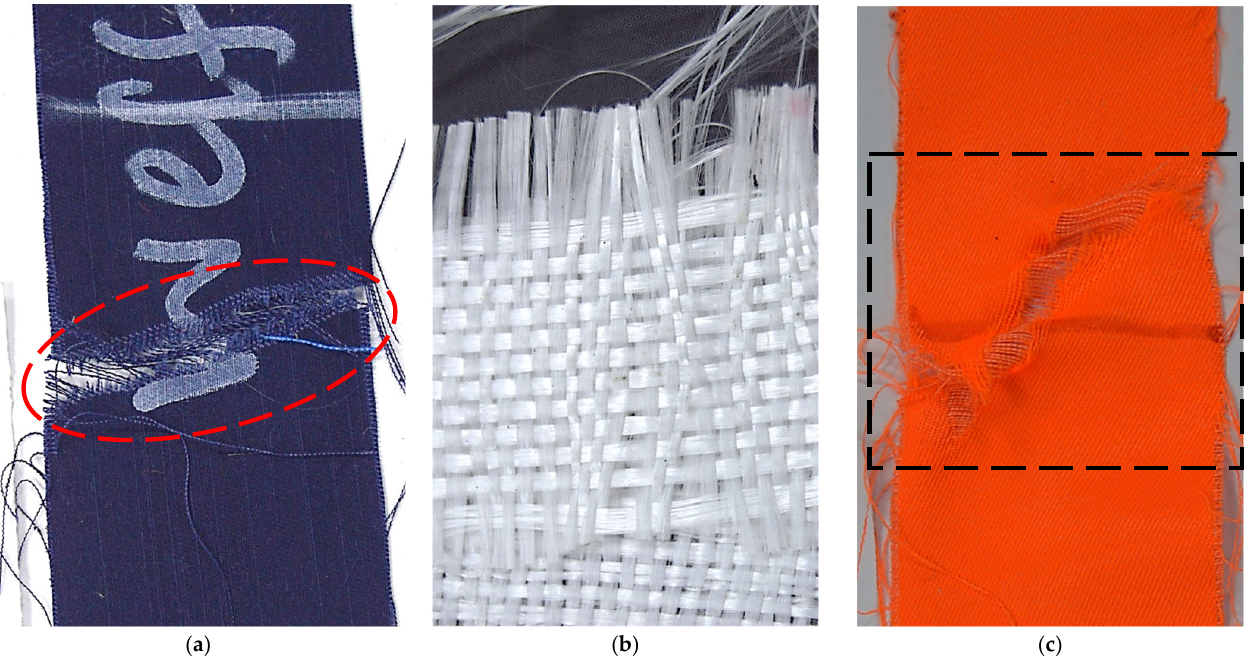
Figure 17. Failure of tested textile fabrics ( a ) TF2 ( b ) TF12 ( c ) TF9.